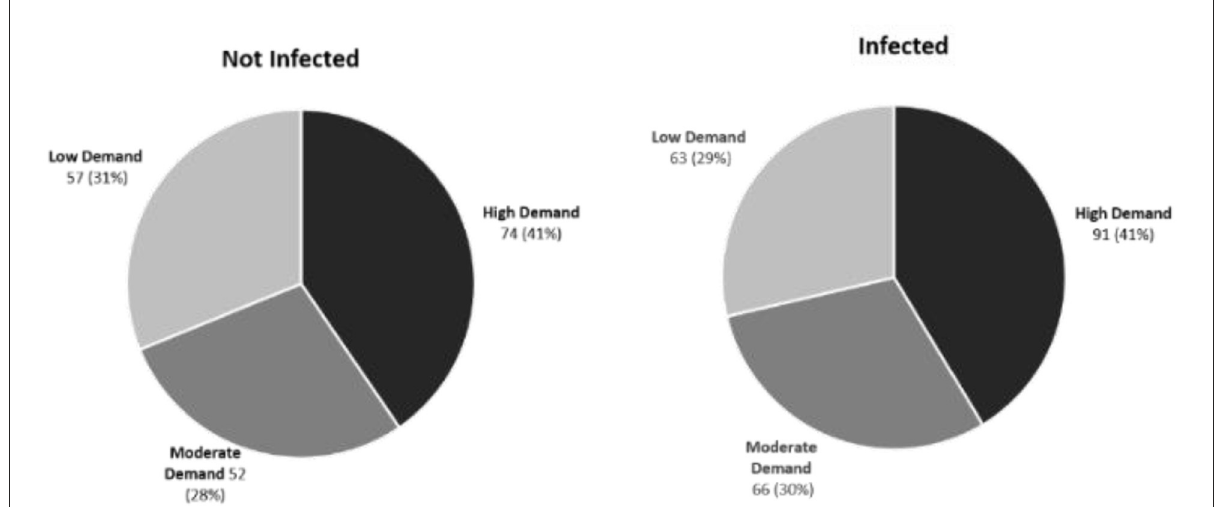
FIGURE5 Market demand for cattle carcases infected or not infected with rumen fluke. No significant difference between the high, medium or low market demand for carcasses sampled from the Dungannon abattoir was demonstrated based on the presence or absence of rumen fluke infection.